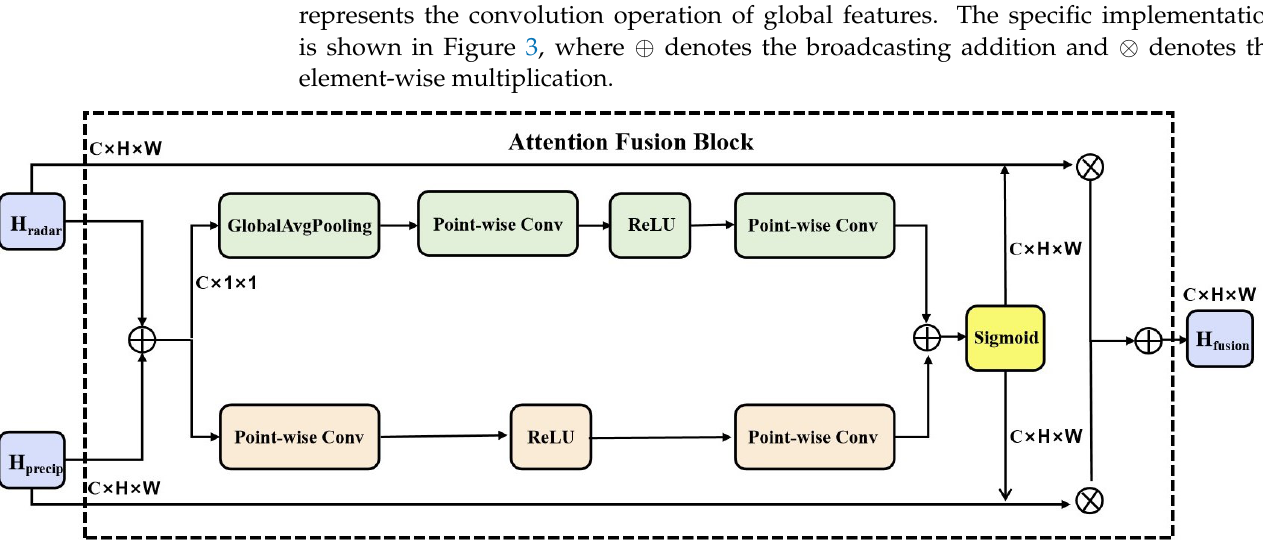
Figure 5. The structure of attention fusion block. By using the attention mechanism, the radar echo hidden state H radar and the precipitation hidden state H precip extracted by encoders are fused to obtain the fusion state H fusion